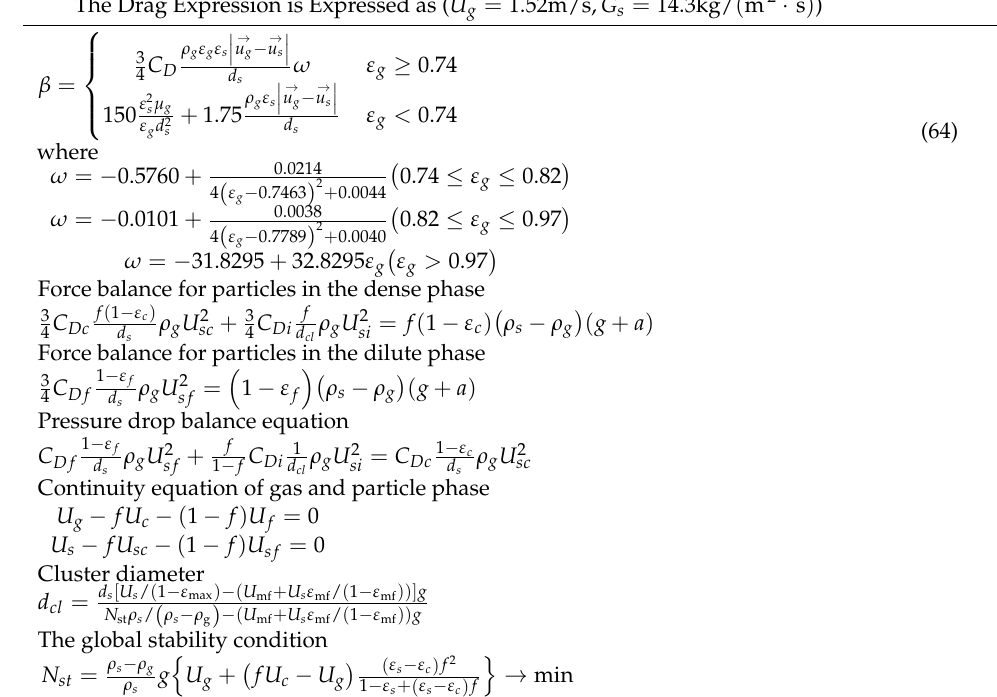
Table 15. Equations for the EMMS model. (Yang et al. [110]). The Drag Expression is Expressed as ( U g = 1.52m/s, G s = 14.3kg/ ( m 2 · s )